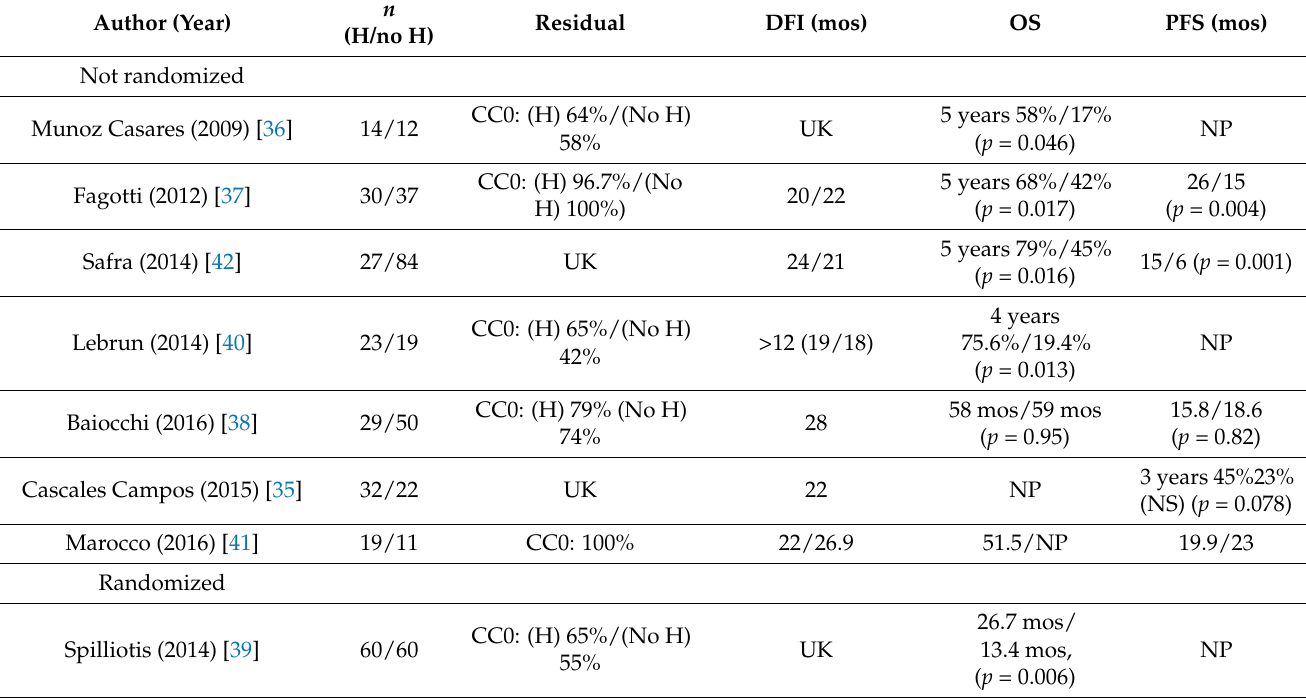
Table 3. Characteristics of the series of cytoreductive surgery and hyperthermic intraperitoneal chemotherapy (HIPEC) for ovarian cancer first relapse with a control group. (PIC O : Population: ovarian cancer first relapse, Intervention: HIPEC, Comparators: HIPEC characteristics, such as in- traperitoneal drug, posology, temperature, duration, no HIPEC groups).